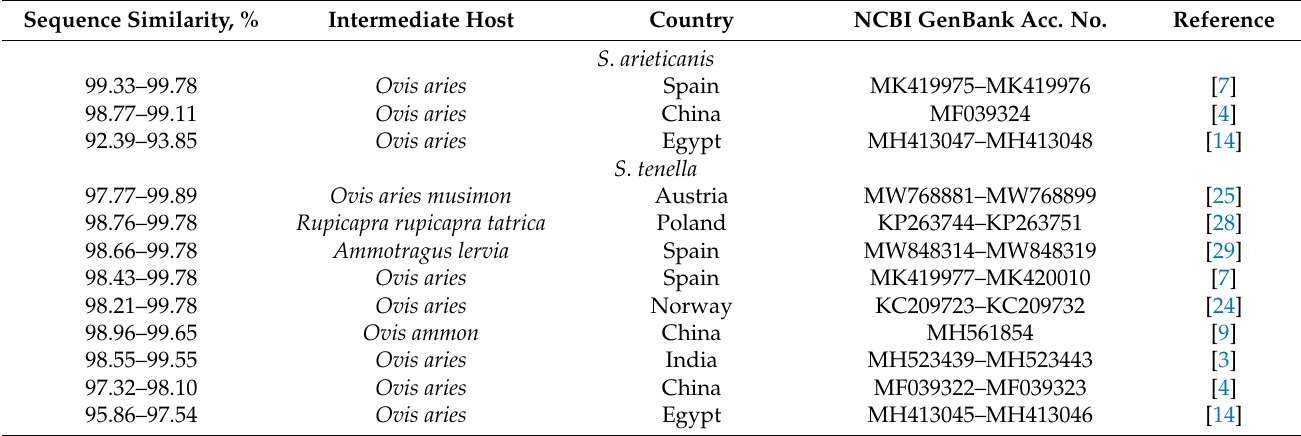
Table 2. Intraspecific genetic variation of S . arieticanis and S . tenella